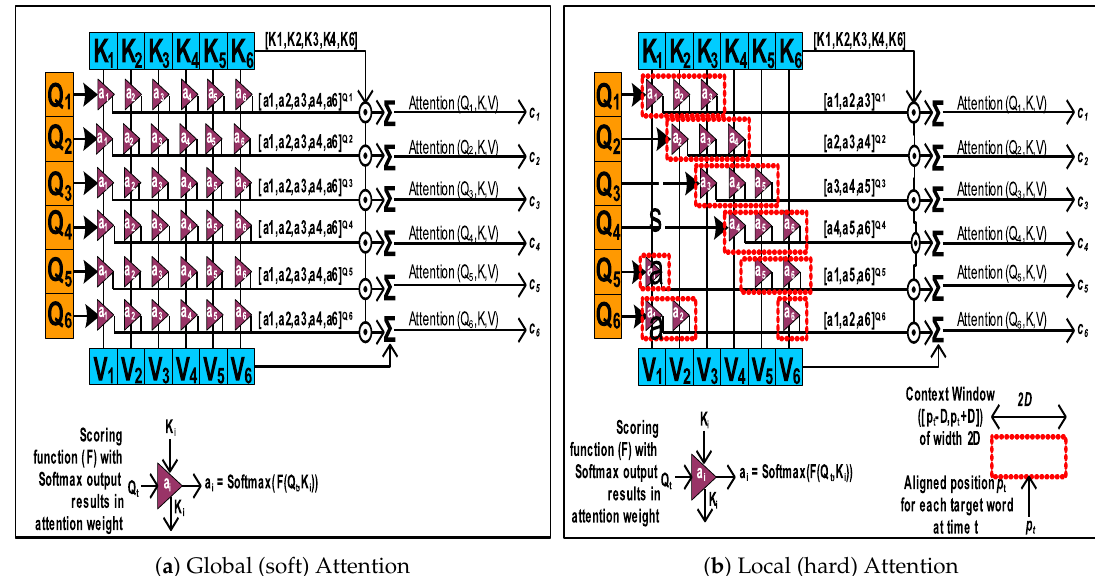
Figure 2. ( a ) Generates variable length (same as input sequence) context vectors [ c 1 , c 2 .., c 6 ] which capture attention weights ( [ a 1 , a 2 .., a 6 ] ) from all input tokens ( K ); ( b ) Generates a fixed length context vector [ c 1 , c 2 .., c 6 ] which capture fixed number of attention weights ( [ a 1 , a 2 , a 3 ] , etc.) from select input tokens selected by a context window which is centred at token index position p t (determined by the model